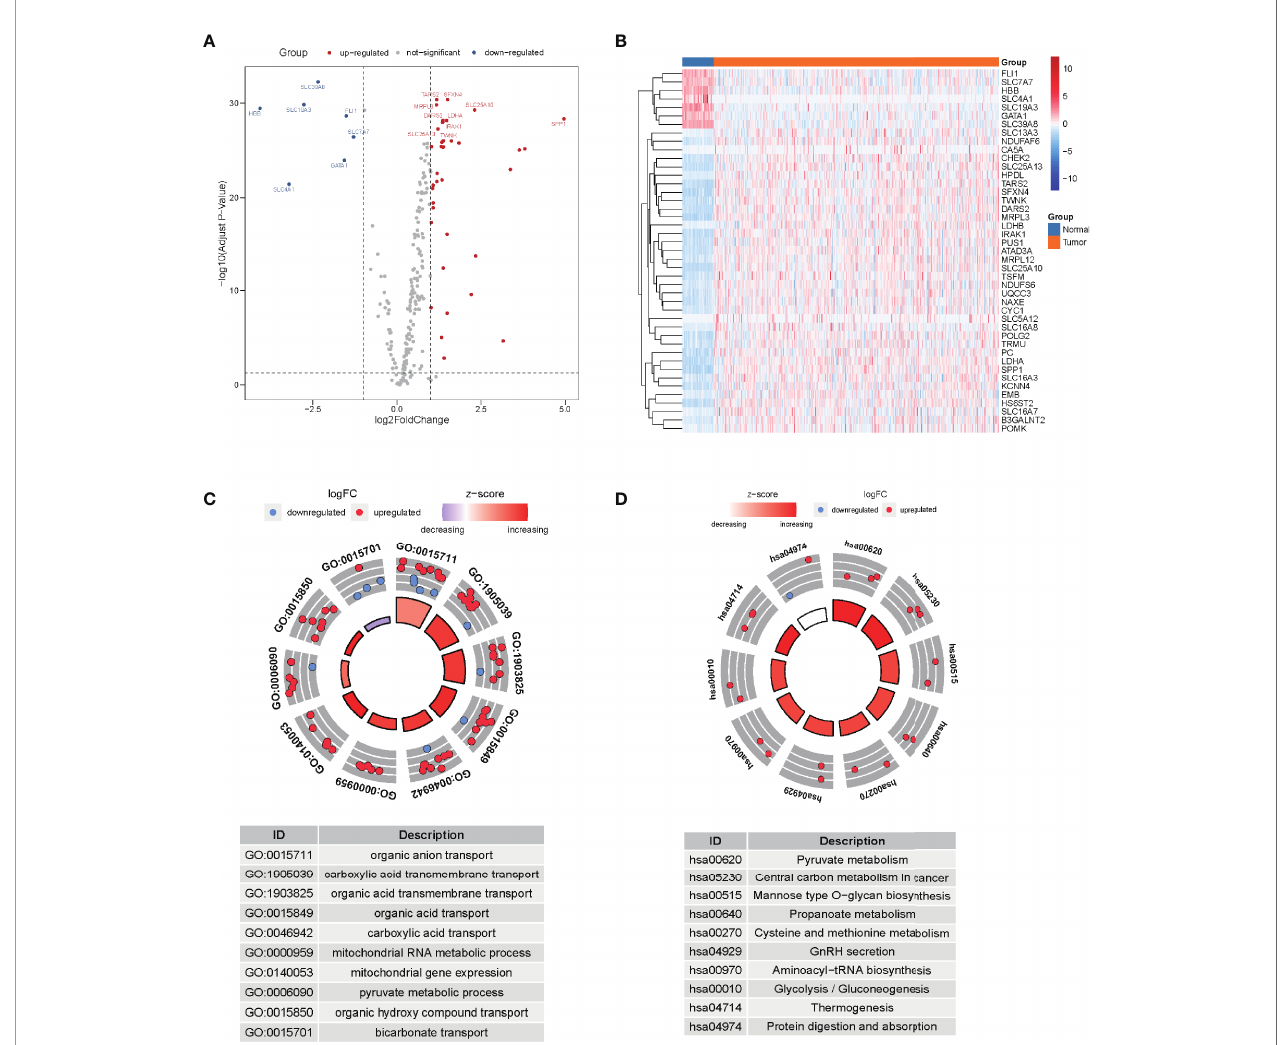
FIGURE 1 | The differential expression of lactate metabolism-related (LMR)-lncRNAs. (A) Volcano plot of differentially expressed genes associated with lactate metabolism. Red dots denote up-modulated genes, while the blue dots down-modulated genes. The plot shows the top gene symbols with the most variance. (B) Heatmap of the expression of 43 LMR genes with a signi fi cant degree of variance in the training cohort. (C) Circle plots of functional enrichment in GO. Red dots denote up-modulation, while the blue dots down-modulation. (D) Circle plot of KEGG enrichment analysis. The Z-score is strongly correlated with the enrichment